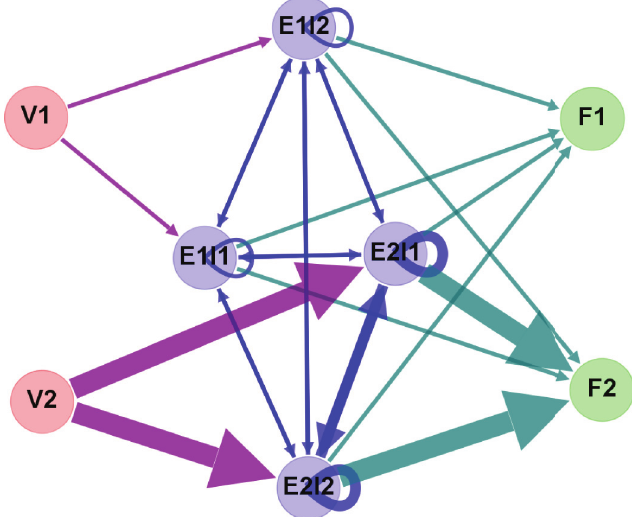
Fig 1. A hypothetical two-economy-two-industry WION. This is a topological view of Table 1. The blue nodes are the individual industries. The label “ ExIy ” should read “ Industry y in Econoomy x ” . The red nodes are the value added sources from the two economies, whereas the green nodes are the final demand destinations in the two economies. The label “ Vx ” should read “ Value Added from Economy x ” , whereas the label “ Fx ” should read “ Final Demand in Economy x ” . The edges are with arrows indicating the directions of the monetary goods flows and with varying widths indicating the magnitudes of the flows. Finally, because we are only concerned with the inter-industrial input-output relationships, when formulating the WION, we focus our attention on the network among the blue nodes.